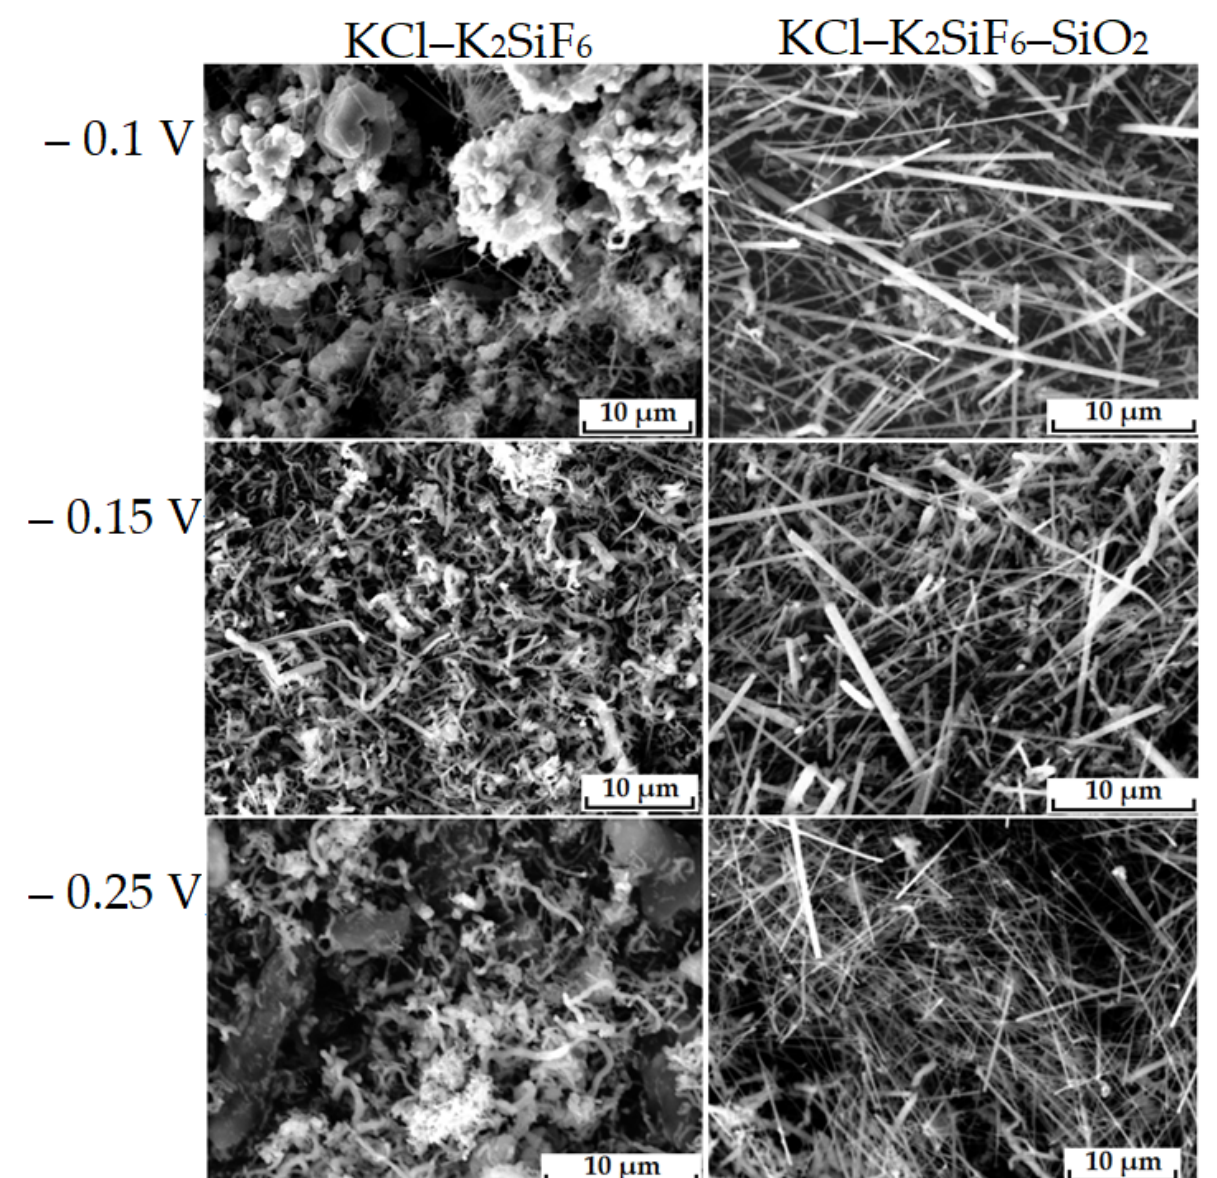
Figure 4. Micrographs of the cathode deposits obtained during the electrolysis of KCl–K 2 SiF 6 and KCl–K 2 SiF 6 –SiO 2 melts at a temperature of 790 ° С and cathode overvoltage of 0.25, 0.15, and 0.1 V vs. QRE.